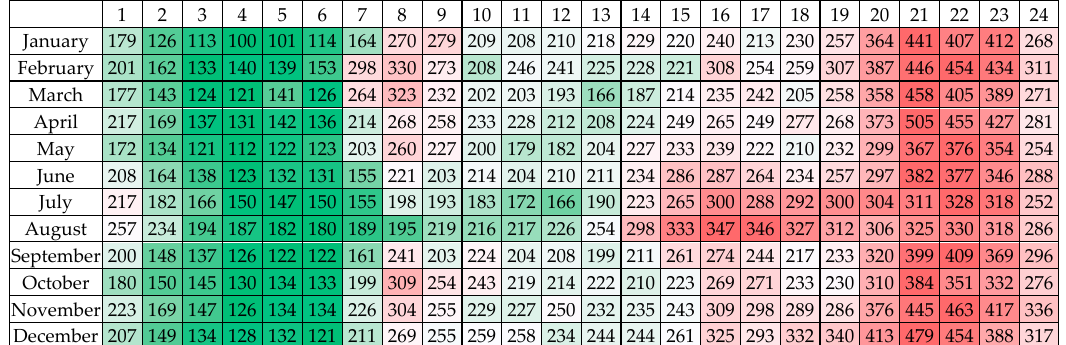
Figure 10. The aggregate profile of average power: weekdays. (Green: low; White: medium; Red: high).